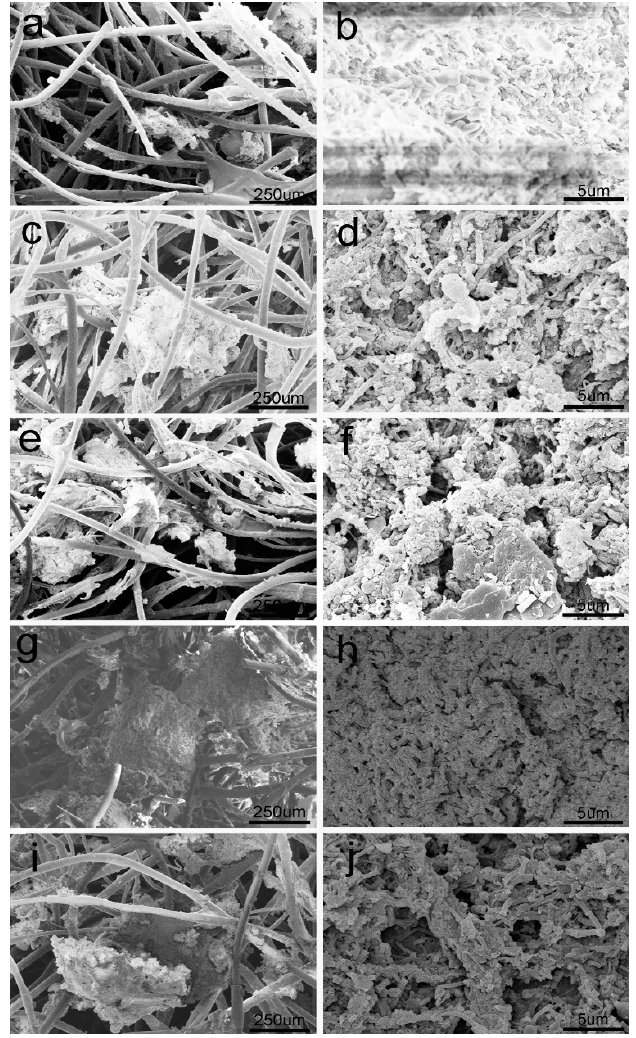
Figure 7. SEM of biofilm on the wool felt in the reactor: ( a , b ): start ‐ up on day 15; ( c , d ): spring on day 90; ( e , f ): summer on day 180; ( g , h ): autumn on day 270; ( i , j ): winter on day 340.